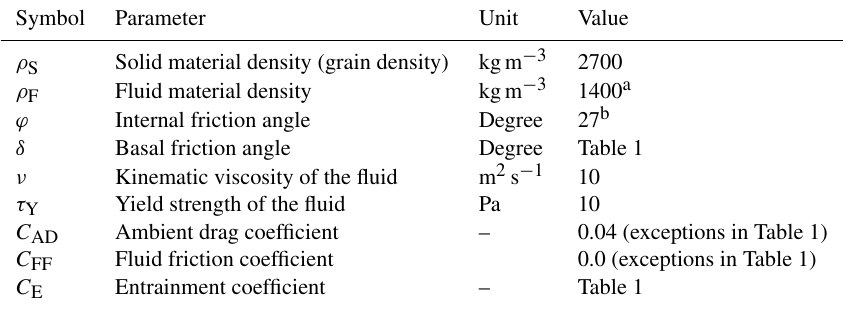
Table 2. Model parameters used for the